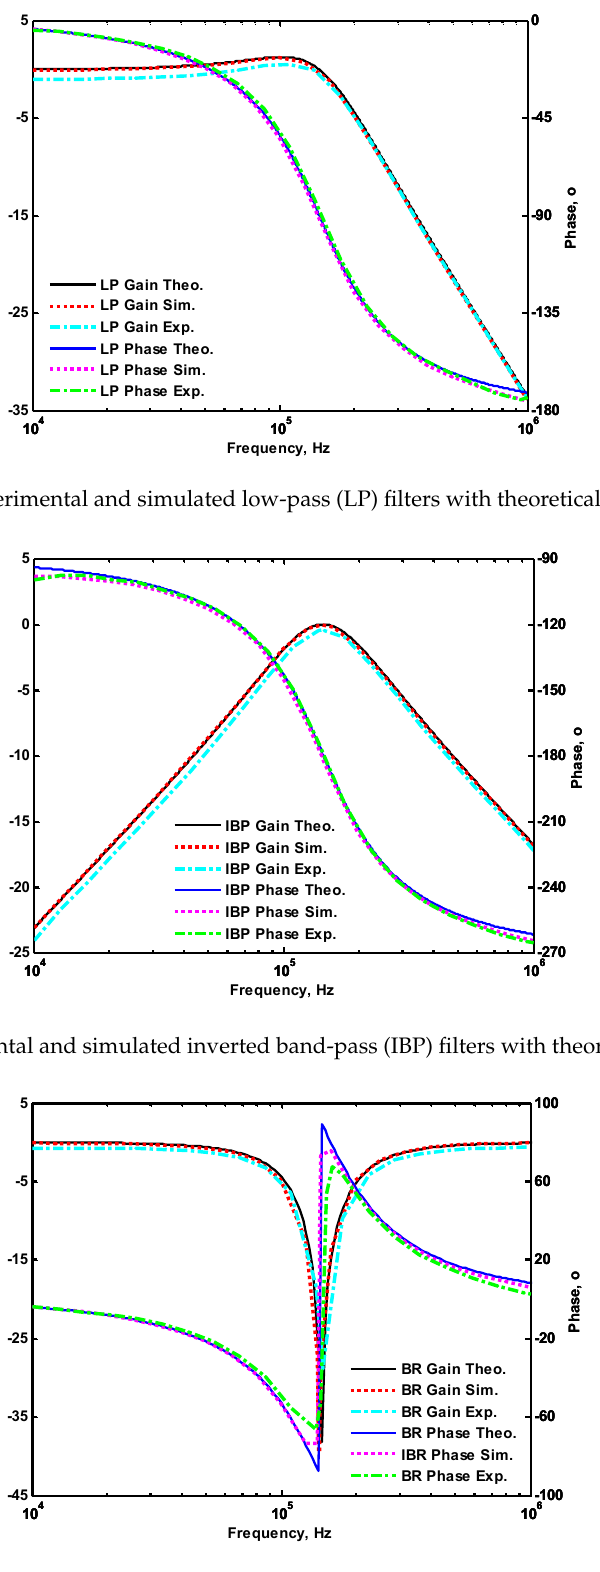
Figure 9. Experimental and simulated band-reject (BR) filters with theoretical responses.